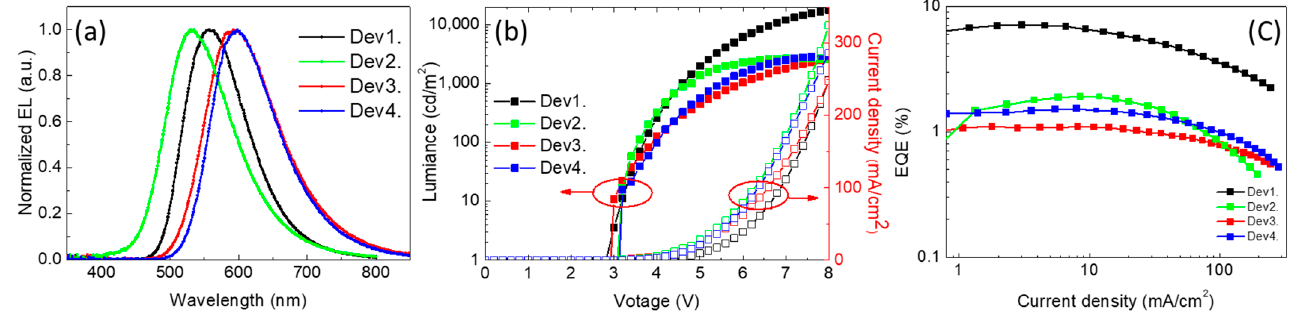
Figure 5. ( a ) Electroluminescence spectra, ( b ) external quantum efficiency (EQE) versus current density characteristics, and ( c ) current density–voltage–luminance curves of devices with different active layers. TAPC:PO-T2T, PVK:PO-T2T, NPB:PO-T2T, and Poly-TPB:PO-T2T devices are denoted as Dev1, Dev2, Dev3, and Dev4, respectively. Table 3. Properties of organic light-emitting diode (OLED) devices for device structure: ITO, PEDOT:PSS (40 nm), exciplex emission (30 nm), POT2T (60 nm), LiF (1 nm), and Al (100 nm). Turn-On Voltage, at Device EL (nm)